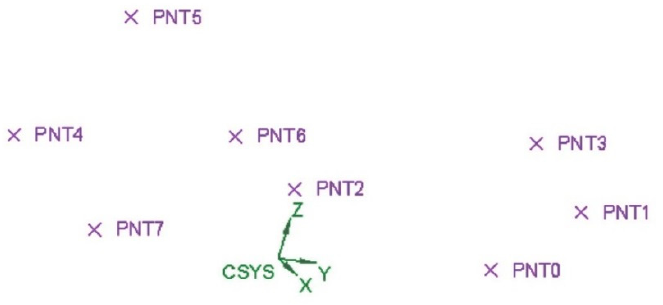
Figure 3. Generation of random points for pore centers, isometric view.